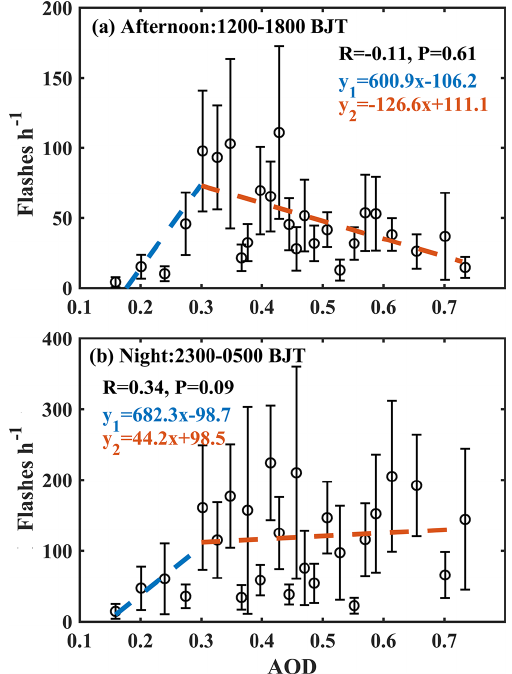
Figure 7. Relationships between lightning flashes and AOD in (a) afternoon (12:00–18:00BJT) and (b) night (23:00–05:00BJT). Note that samples are first sorted by AOD and then samples with similar AOD were averaged to create the presented scatter plot. The max number of samples in each bin is equal to or less than 20. The difference between the maximum and minimum AOD values of samples in each bin is equal to or less than 0.05. An estima- tion of the uncertainty was calculated from the standard deviation of each bin divided by the square root of the number of data points in the bin. Linear-fit lines, Pearson correlation coefficients ( R ), and significant level ( P ) are also